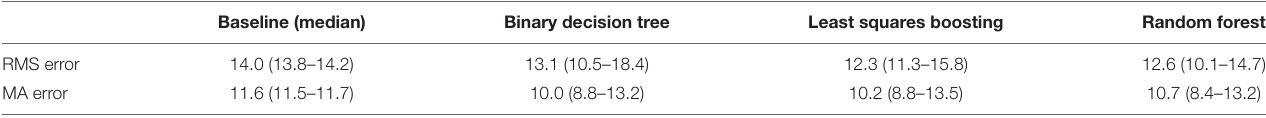
TABLE 2 | Medians and interquartile ranges of root-mean-square (RMS) and mean absolute (MA) errors for the baseline estimator (median of other 17 dyads) and for three machine learning methods in dyad-non-specific engagement estimation. Baseline (median)